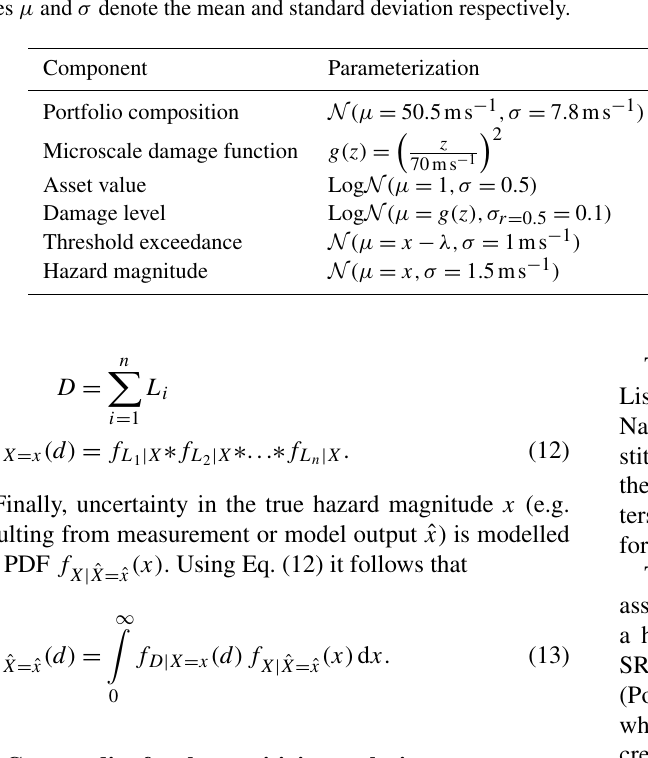
Table 3. Parameterization of the probabilistic damage function for the storm-damage simulation for a German building portfolio. The vari- ables µ and σ denote the mean and standard deviation